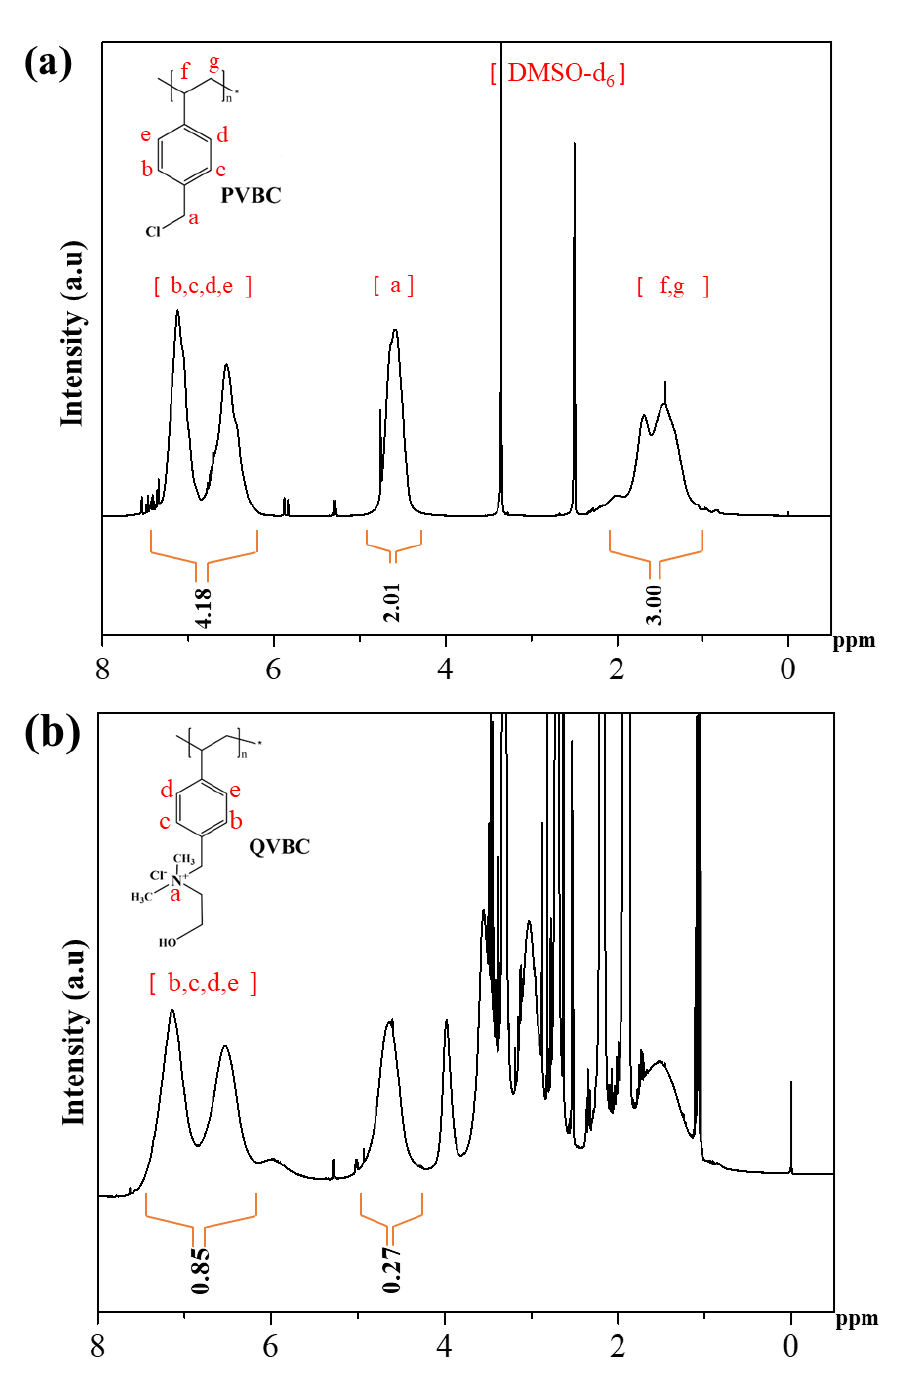
Figure 7. ( a ) 1 H-NMR spectra of PVBC and ( b ) QVBC-quaternized PVBC.